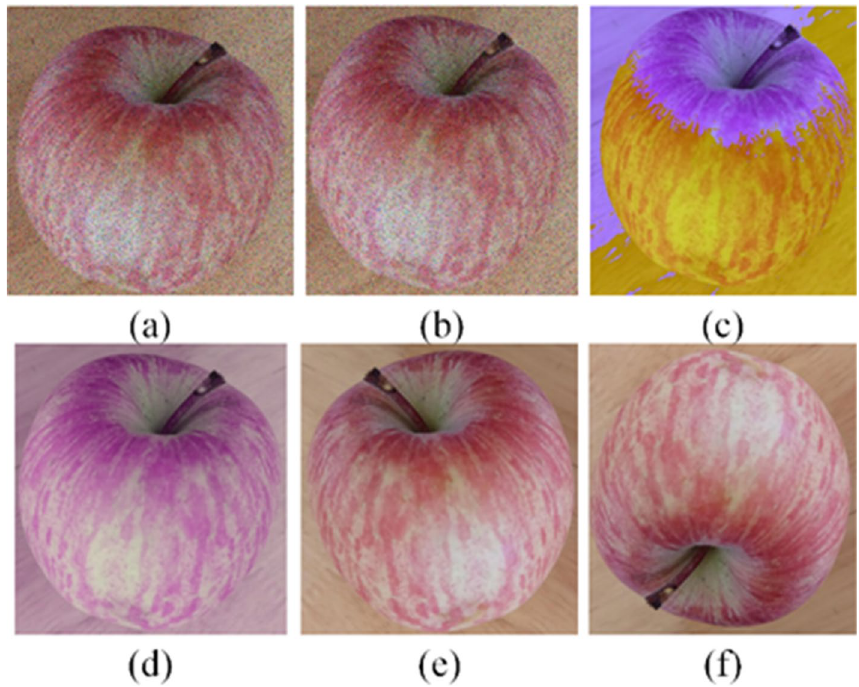
Figure 3. Representative augmented images: ( a ) increasing salt and pepper noise; ( b ) increasing Gaussian noise; ( c ) brightness; ( d ) darkness; ( e ) flips; ( f ) rotation at 180°.